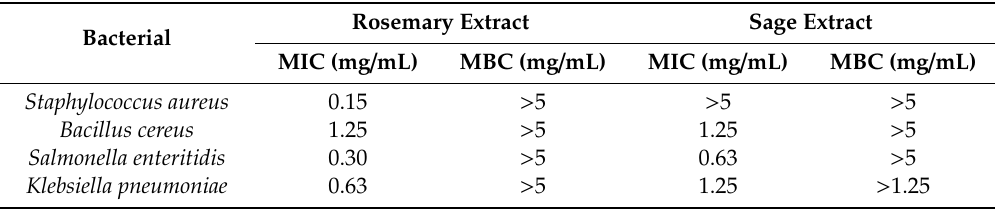
Table 3. Antibacterial activity of rosemary and sage extracts. Rosemary Extract Sage Bacterial